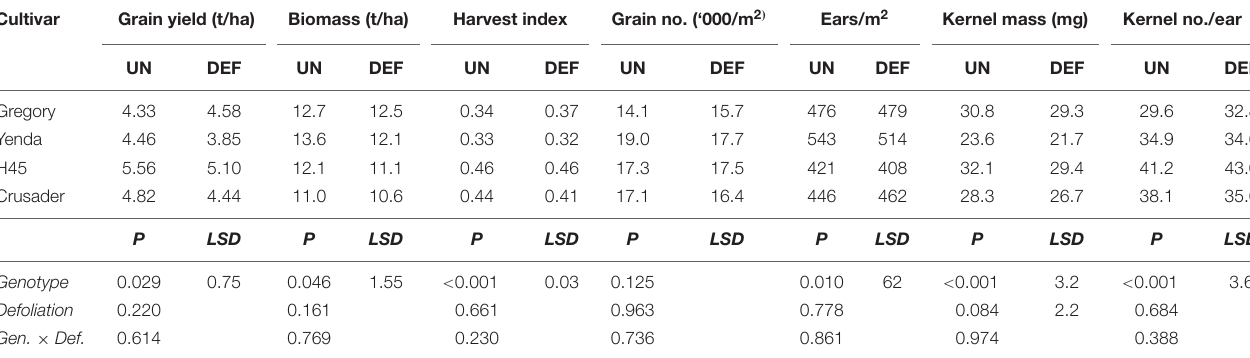
TABLE 7 | Grain yield and yield components at harvest of four spring wheat cultivars following defoliation at GS26 (DEF) compared to an undefoliated control (UN) (Experiment 3 – Brookstead, 2013). Cultivar Grain yield (t/ha) Biomass (t/ha) Harvest index Grain no. (‘000/m 2 ) Ears/m 2 Kernel mass (mg) Kernel no./ear UN DEF